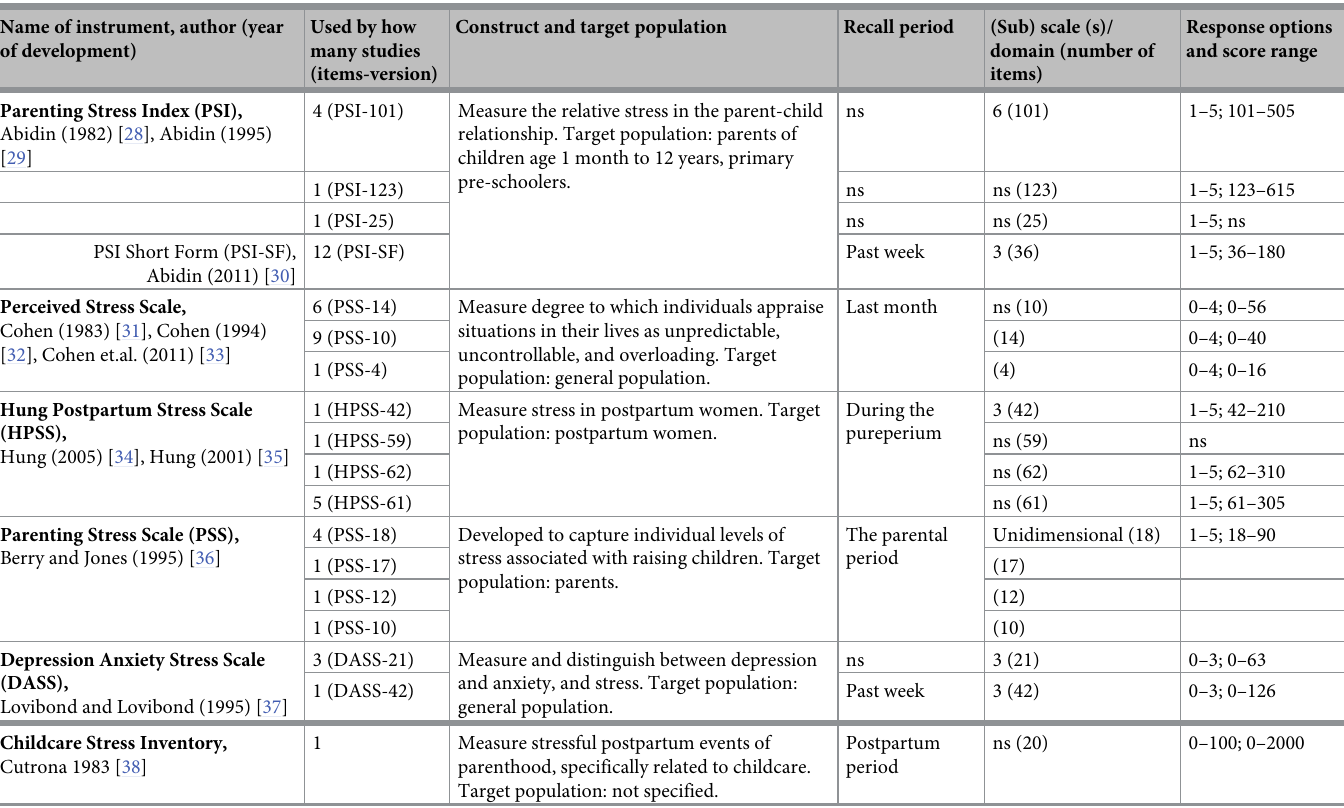
Table 2. Characteristics of the included